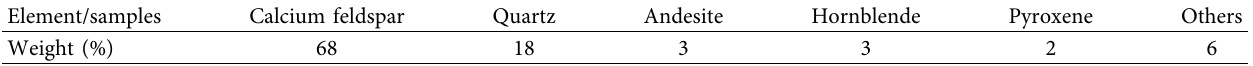
Table 1: Mineral composition of the samples used.